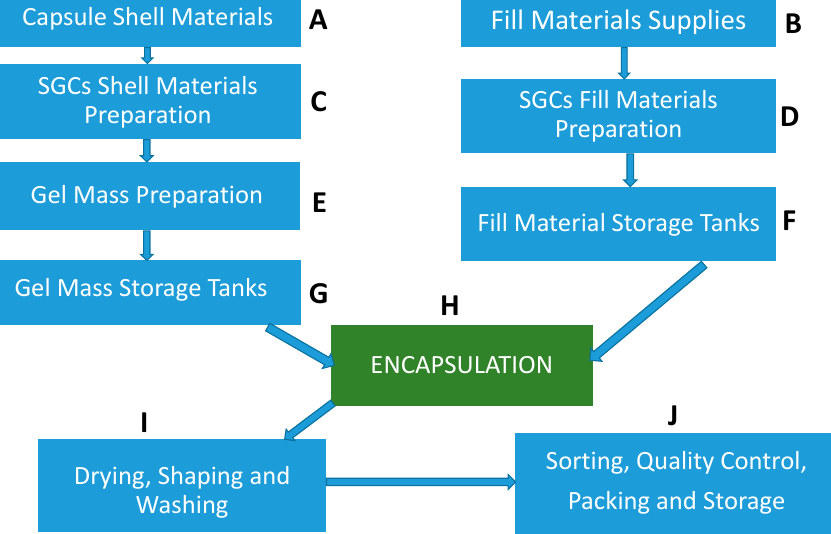
Figure 3. Schematic representation of ( A – J ) different steps in the manufacturing of SGCs.